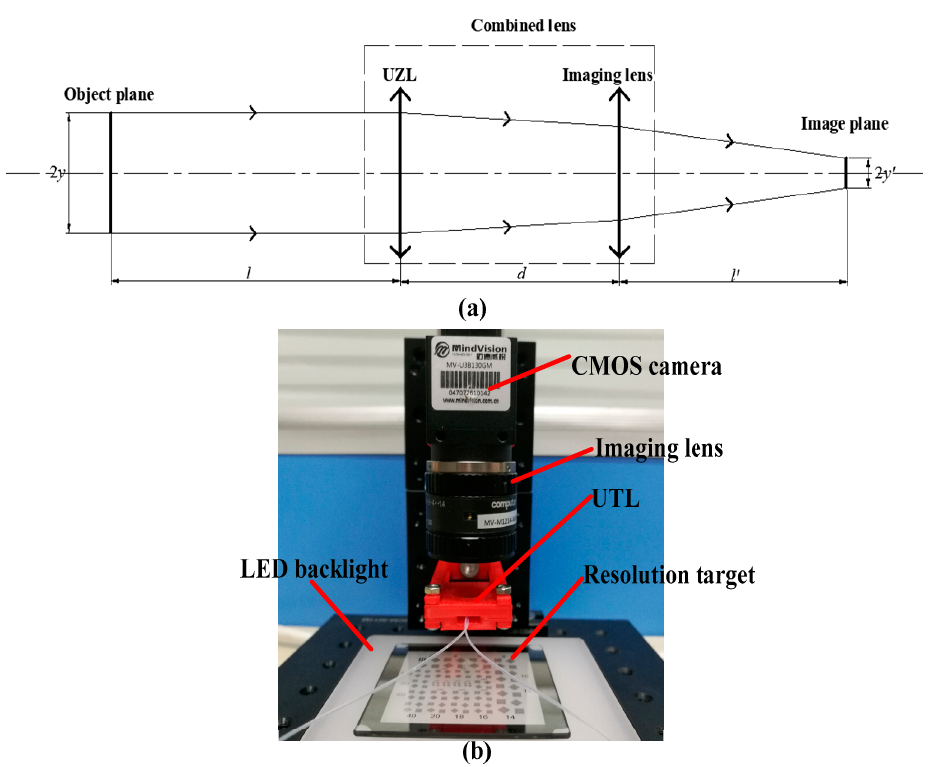
Figure 9. ( a ) Experimental principle and ( b ) experimental device.